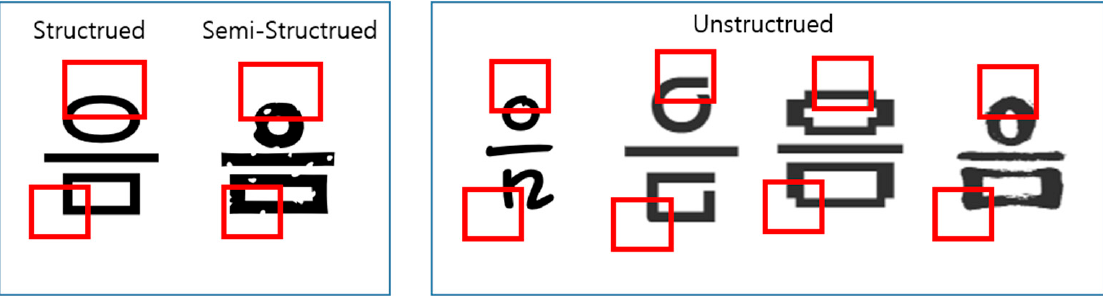
Figure 11. Difference in appearance of the same stroke element by group.